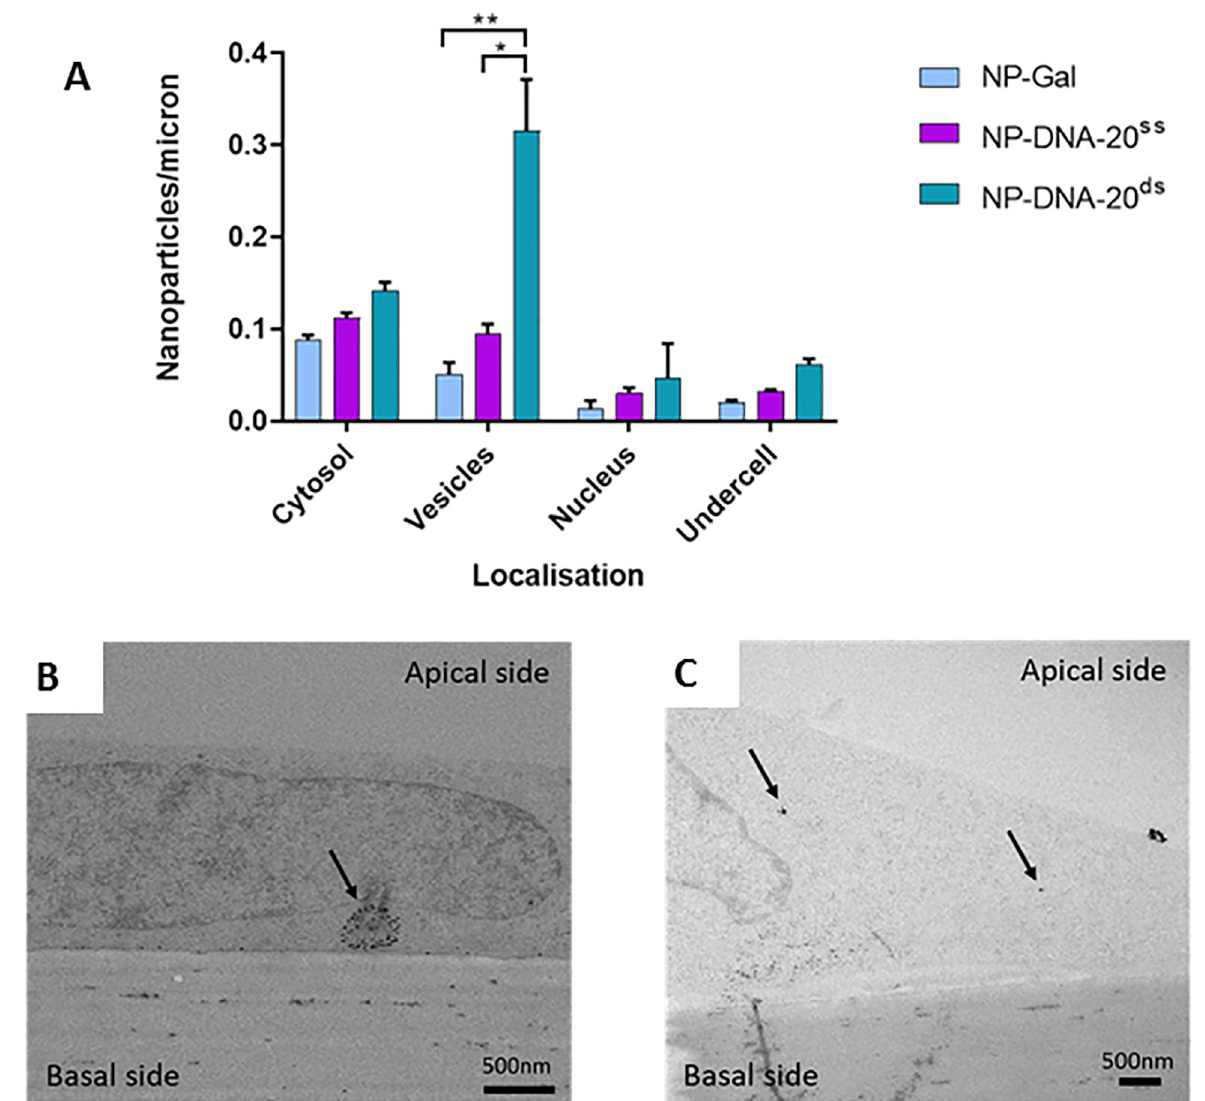
Fig 2. Endocytosis of gold nanocarriers with ssDNA or dsDNA by brain endothelium. (A) Nanoparticles in cytosol, vesicles and the nucleus of hCMEC/D3 cells. NPs with 20nt ssDNA (NP-DNA-20 ss ) were compared with dsDNA(NP-DNA-20 ds ) and the base nanoparticles (NP-Gal). Three experiments were performed, each individual experiment with three technical repeats. Tukey’s multiple comparisons test showed a significant difference for NP-DNA-20 ds compared to NP-Gal ( �� P = 0.0034) and NP-DNA-20 ss ( � P = 0.0133) in vesicles. (B) Transmission electron micrographs showing examples of silver enhanced gold NPs in vesicles (NP-DNA-20 ds , A) or the cytosol (NP-Gal, B) of hCMEC/D3 cells after application to the apical surface.